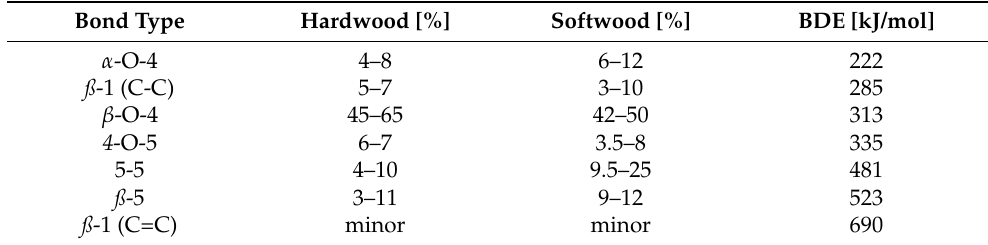
Table 2. Overview of the bond types occurring in lignin listed in the order of increasing bond dissociation energies. Data are summarized from references